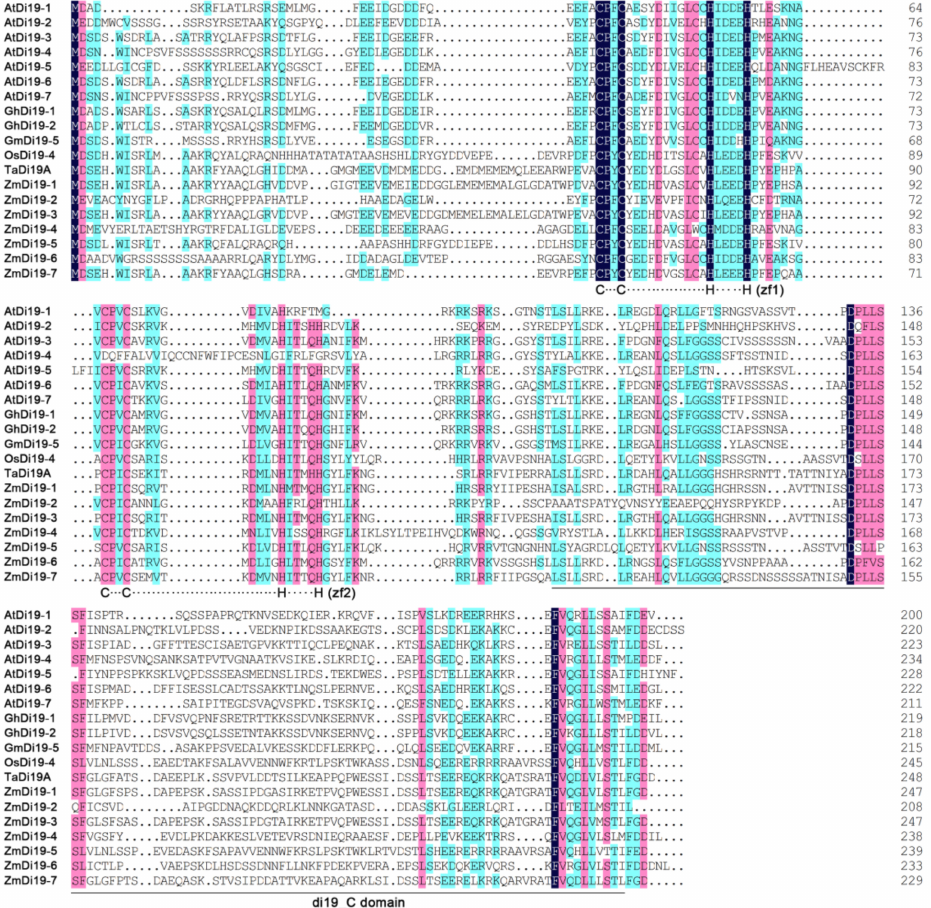
Figure 1. Sequence alignments of maize, Arabidopsis, and other Di19 members with known functions. Sequences were aligned by DNAMAN software, and identical or similar residues were highlighted in different